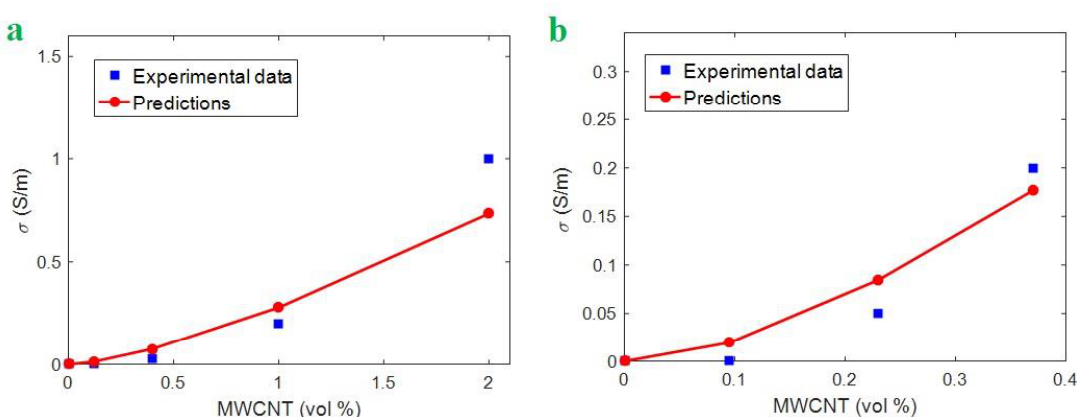
Figure 1. Comparison between experimental and theoretical data (Equation (12)) for ( a ) epoxy / MWCNT [55] and ( b ) UPE / MWCNT [58] samples.